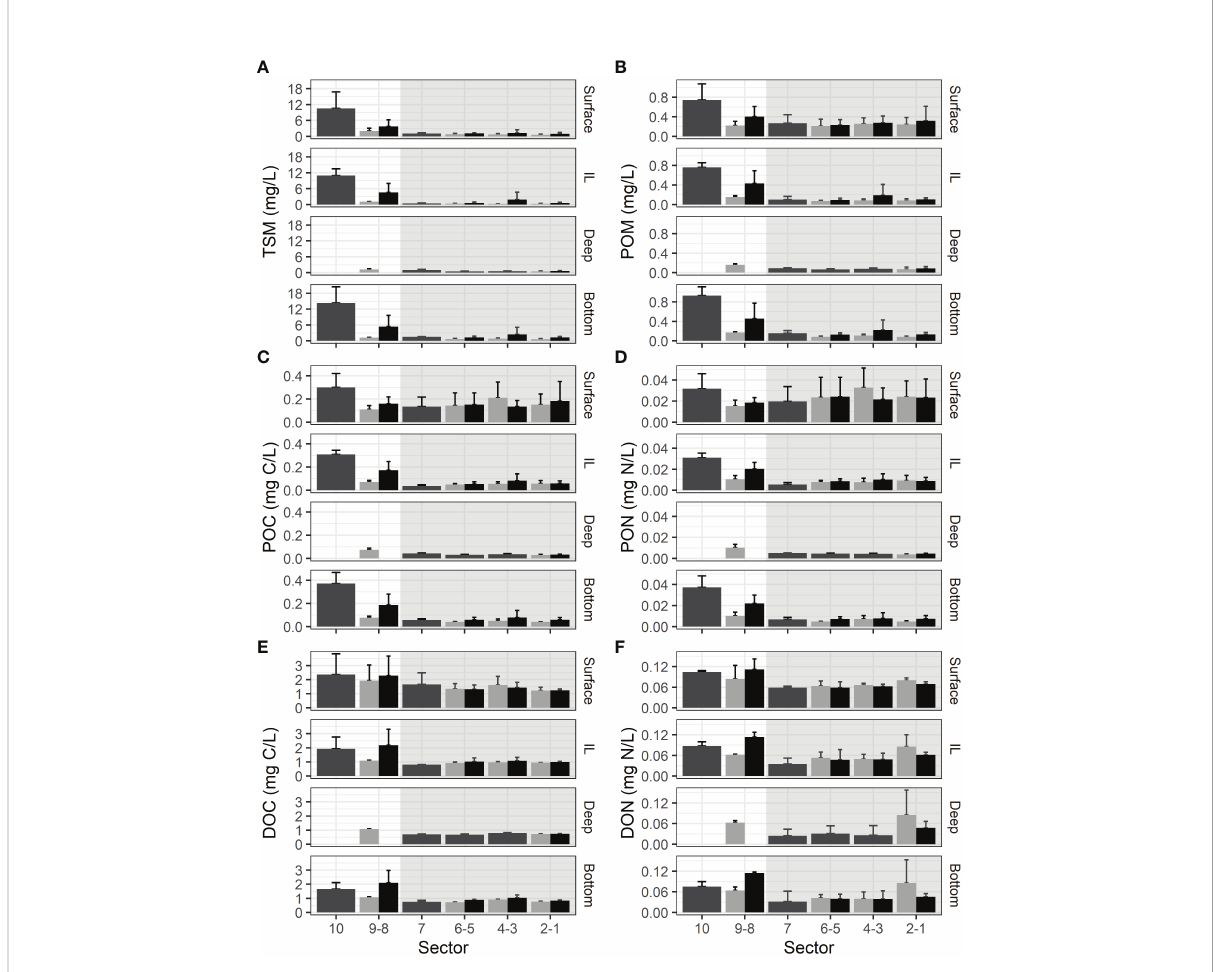
FIGURE 3 Concentrations(mean±sdcalculatedforthreetimeperiods)of (A) TSM, (B) POM, (C) POC, (D) PON, (E) DOC, and (F) DONfortheSt. Lawrenceestuaryin 10 sectors, for each depth class. Darkgray=wholecross-section, palegray=northof thalweg,black=southofthalweg. White background = USLE (downstream of the maximum turbidity zone), and gray background = LSLE. The depth of the USLE only reach the deep layer in sector 9.